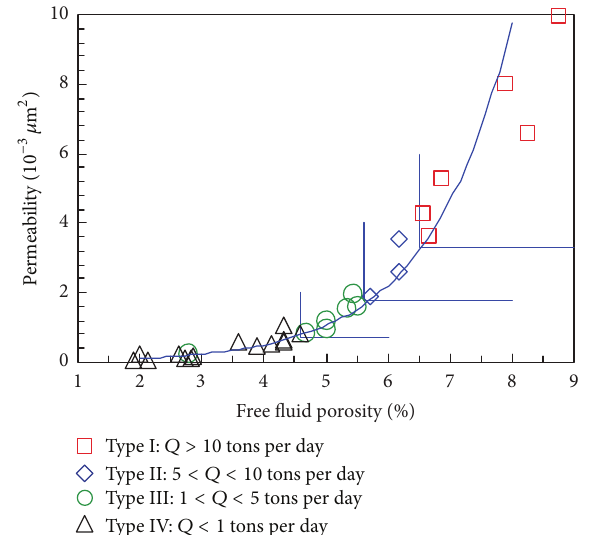
Figure 6: The natural fluid production capacity ( Q ) prediction